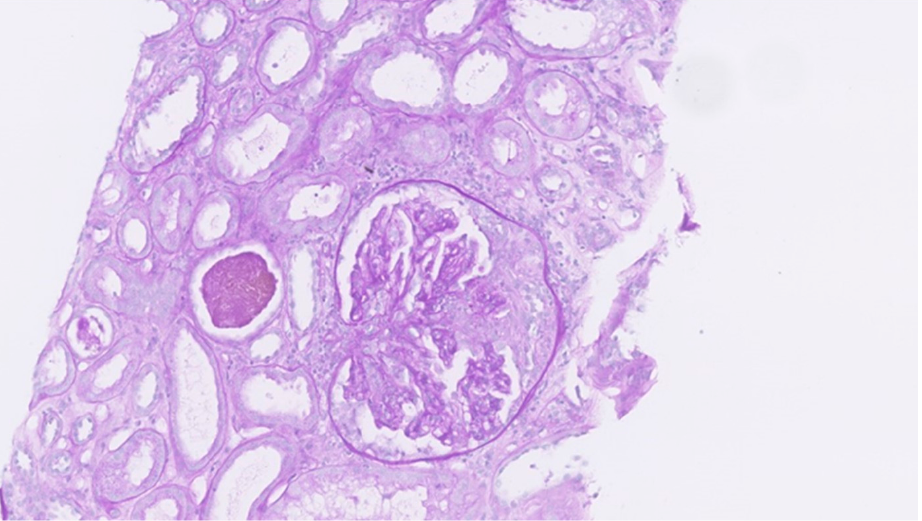
Figure 7. Left kidney: the biopsy showed crescentic glomerulonephritis with focal fibrinoid necro- sis of the glomerular tufts end extracapillary proliferation in five out of seven glomeruli. Immuno- fluorescence was negative and consistent with pauci-immune ANCA-associated glomerulonephri- tis.